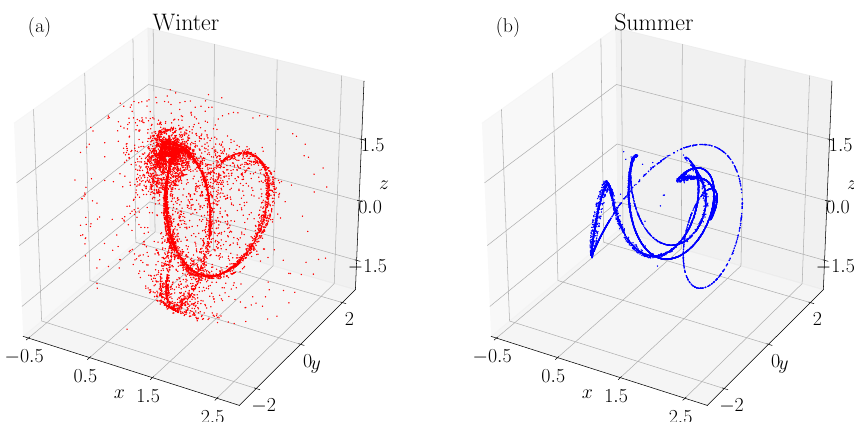
Figure 2. (a) Winter snapshot attractor of the Lorenz84 model. (b) Summer snapshot attractor of the Lorenz 84 model. Each of 10000 points is the solution at time 5 τ 5 73 of the Lorenz 84 equation (see Eq. 2), and constructed with a time step of integration of 0 . 005 using RK4 = × scheme.